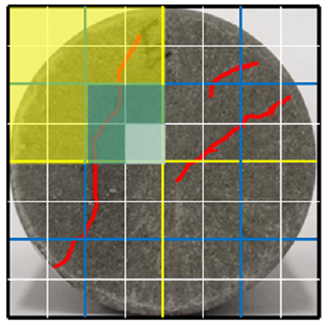
Figure 2. Schematic diagram of the box theory. The red lines represent fractures.